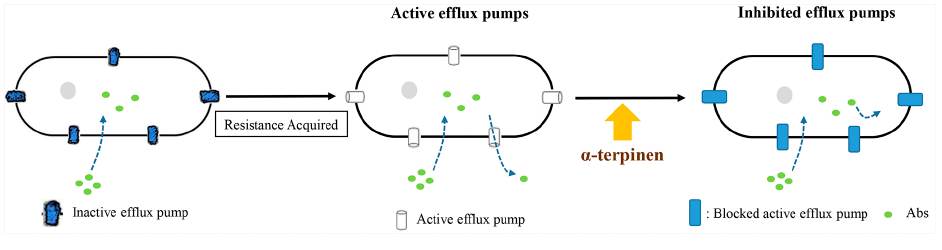
Figure 11. α -terpinen blocks the antibiotic-resistance of Staphylococcus aureus through NorA efflux pump inactivation (modified from de Morais Oliveira-Tintino et al. 2018 [109]).